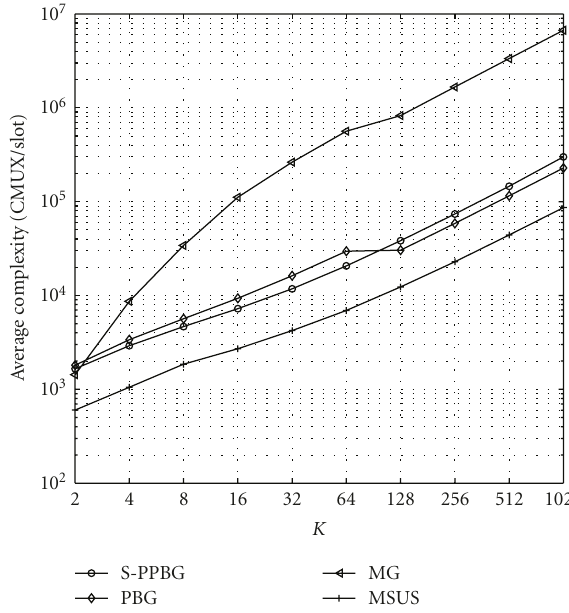
Figure 3: Average sum rate versus the total number of users K . Scheduling objective is proportional fair scheduling.